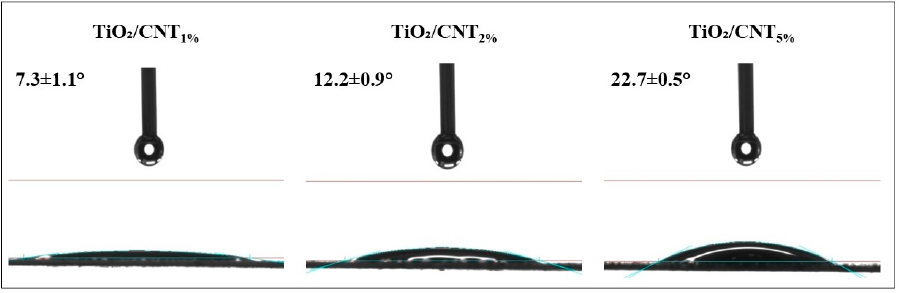
Figure 1. Contact angles formed between the given titanium dioxide/carbon nanotube (TiO 2 /CNT) nanocomposite-coated membrane surface and the ultrapure water droplet (10 µ L), measured immediately (within 1 s) after dropping.